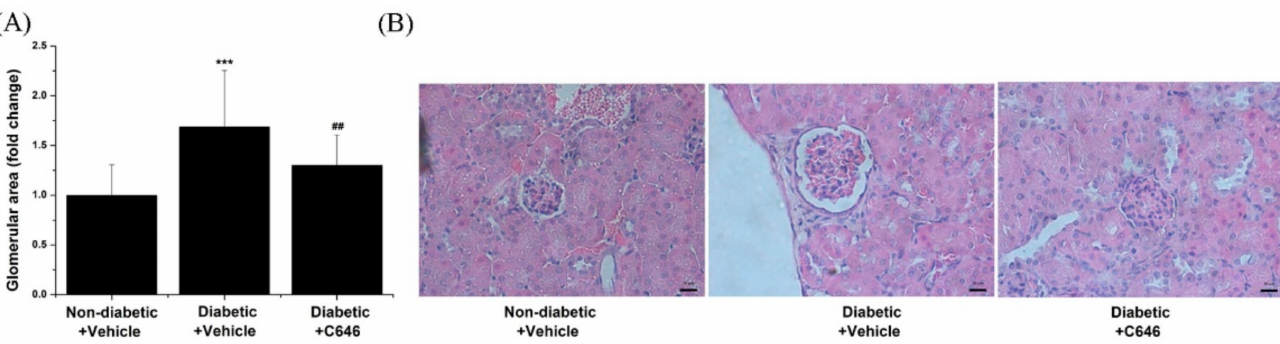
Figure 8. Long-term administration of C646 pharmacological inhibitor of p300/CBP prevents glomerular hypertrophy in diabetic mice. ( A ) Quantification of the relative glomerular area in each experimental animal group. ( B ) Representative hematoxylin-eosin phase-contrast microscopy images taken at 40 × magnification depicting the staining of glomeruli. Note that C646 treatment of diabetic mice reduced significantly the relative glomerular hypertrophy to the level of control non-diabetic mice. n = 23/condition quantified glomeruli, *** p < 0.001, p -values taken in relation to non-diabetic + vehicle condition; ## p < 0.01, p -values taken in relation to diabetic + vehicle